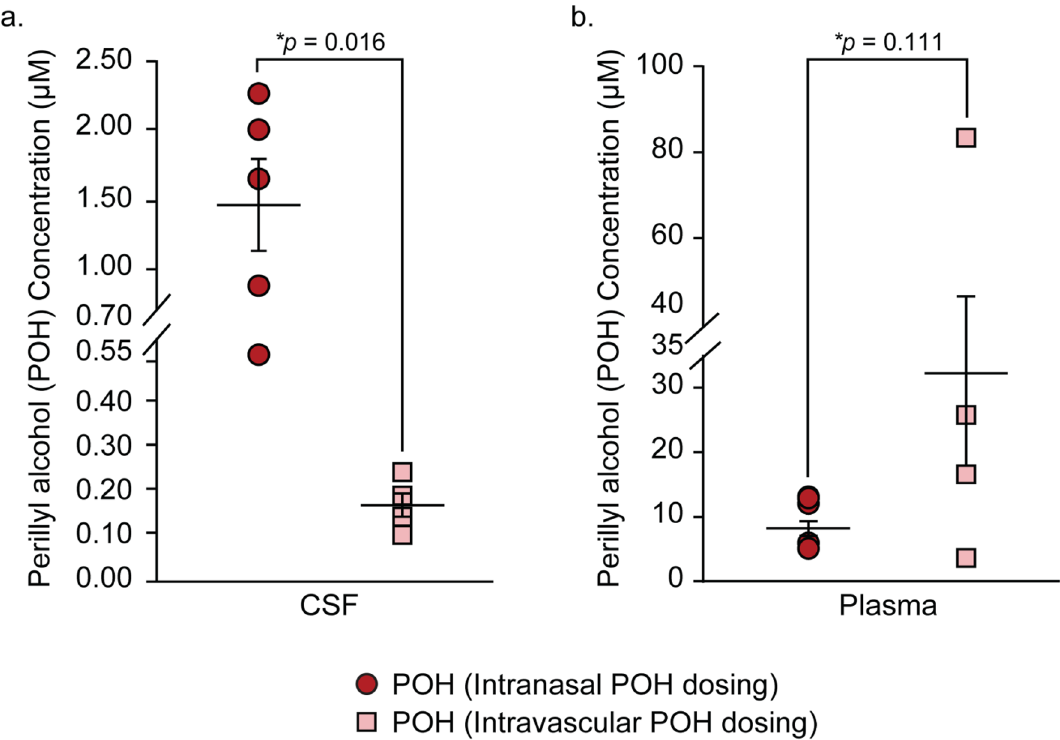
Figure 2. Average POH concentration in the CSF and plasma following equal-dose intranasal and intravascular POH administration. (a) Concentration of POH in the rat CSF following intranasal (red circles) and intravascular (pink squares) POH administration. (b) Concentration of POH in the rat plasma following intranasal (red circles) and intravascular (pink squares) POH administration. * p values calculated by Mann– Whitney rank sum